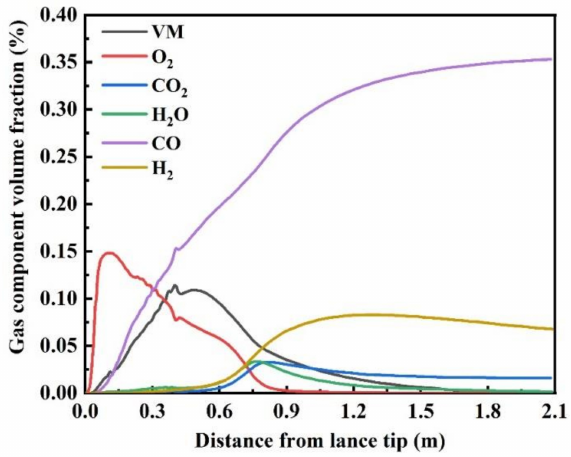
Figure 9. Gas distribution in the direction of the coal lance